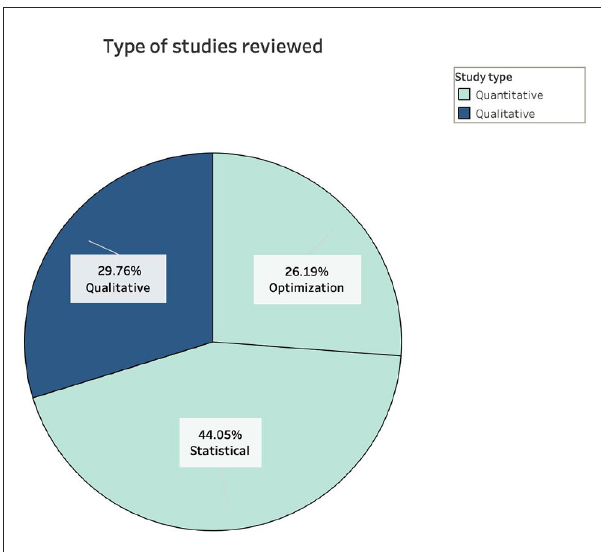
FIGURE4 Research in vaccination strategies using PBI for different